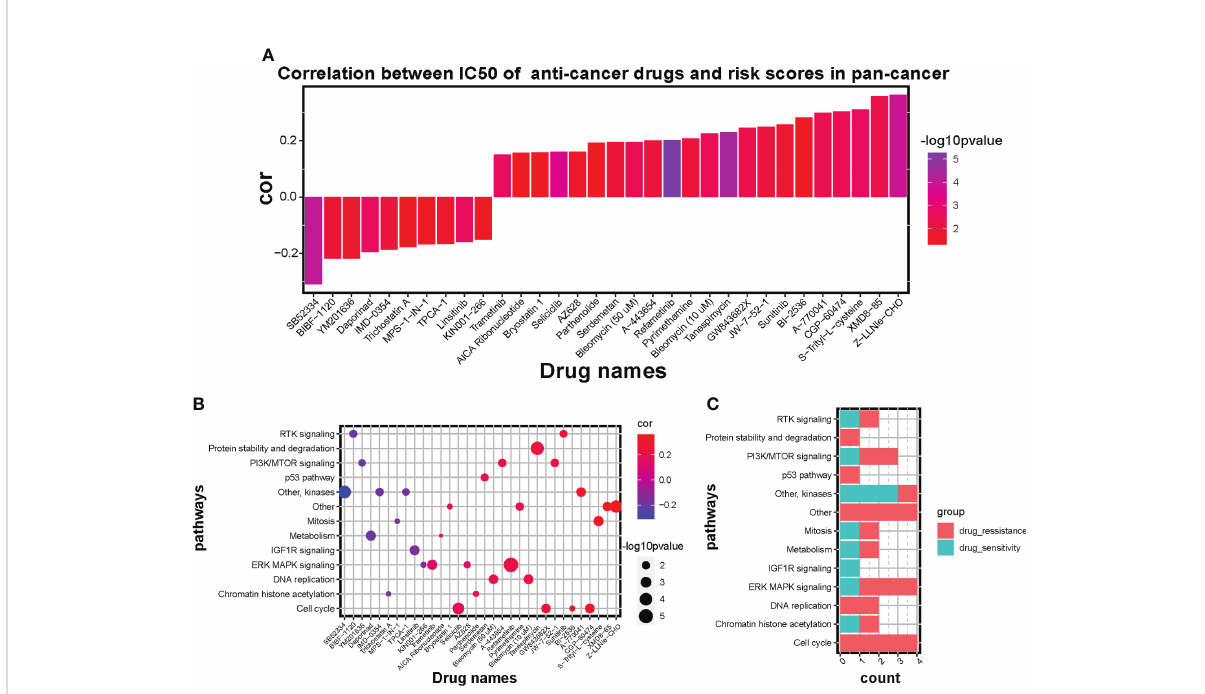
FIGURE 8 In fl uence of the risk signature on drug sensitivity and resistance in GSDC pan-cancer cell lines. (A) Bar diagram of correlation between IC50 of anti-cancer drugs and risk scores in pan-cancer. Altitude represents the correlation, higher the altitude, higher the correlation. Color represents statistical signi fi cance (p value), the more purple the color, the greater the signi fi cance. (B) Scatter diagram of correlation between targeted signaling pathways and IC50 of signi fi cant anti-cancer drugs. Size of plots represents statistical signi fi cance (p value), the larger the size, the greater the signi fi cance. Color of plots represents the correlation between targeted pathways and anti-cancer drugs. Red represents positive correlation and blue represents negative correlation. Purple represents little correlation. (C) Bar diagram shows the counts of sensitive drugs and resistant drugs regarding the targeted